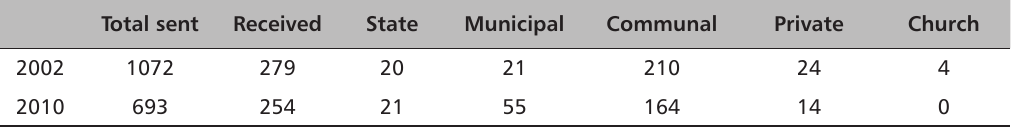
TABLE 2. Structure of respondents according to forest ownership